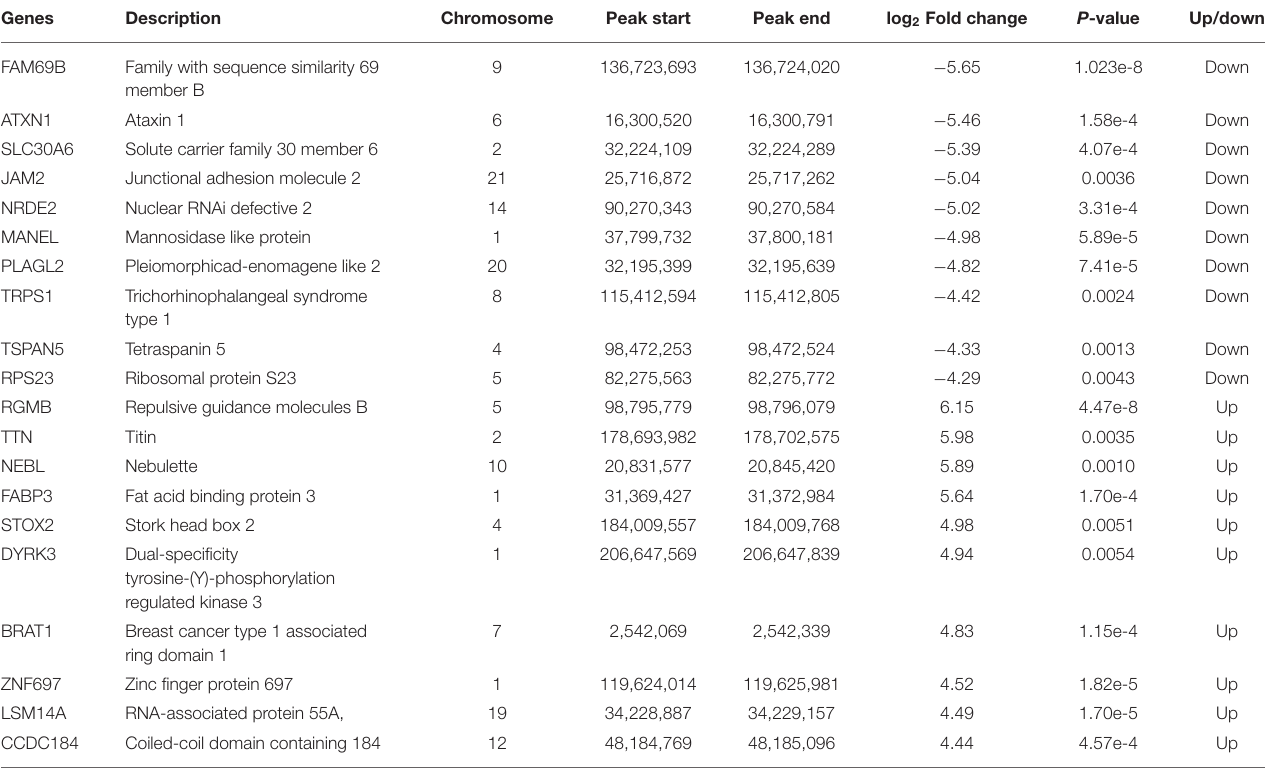
TABLE 1 | List of the top 10 hypomethylated genes and the top 10 hypermethylated genes. Genes